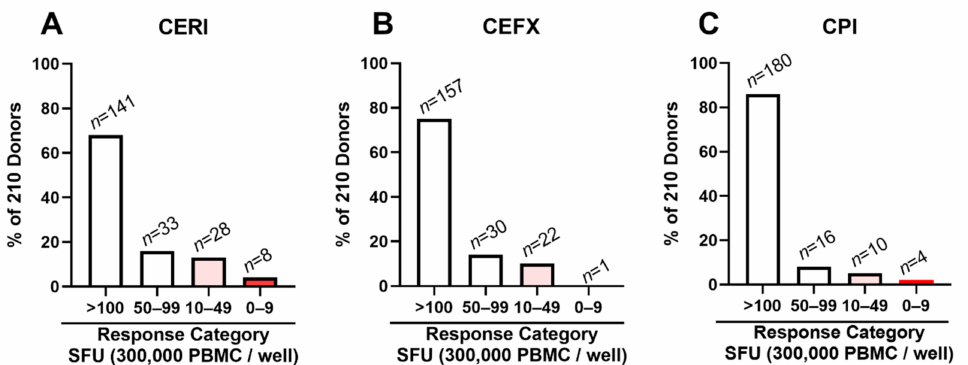
Figure 4. CERI ( A ), CEFX ( B ) and CPI ( C )-triggered recall responses in 210 healthy human donors. A standard 24 h IFN- γ ImmunoSpot ® assay was performed testing the antigen-induced SFU numbers. Response magnitudes have been divided into the specified response categories. The percentage of subjects falling into each response category is shown on the Y -axis, and the number of subjects in each category is specified above the